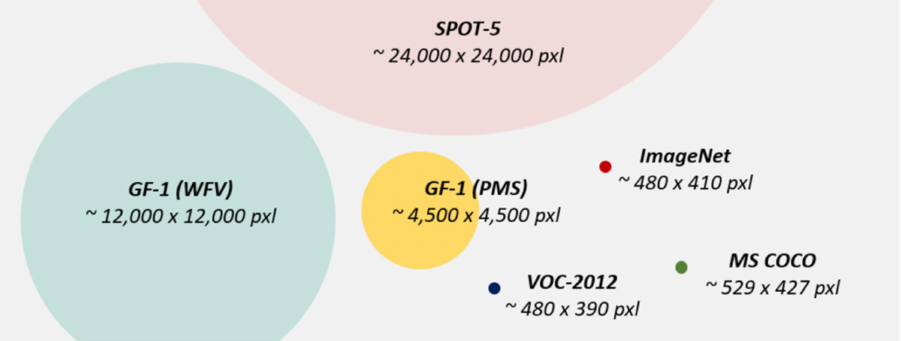
Figure 1. Data volume comparison between a single-view remote sensing imagery and an average image size for VOC, ImageNet, and COCO [48].